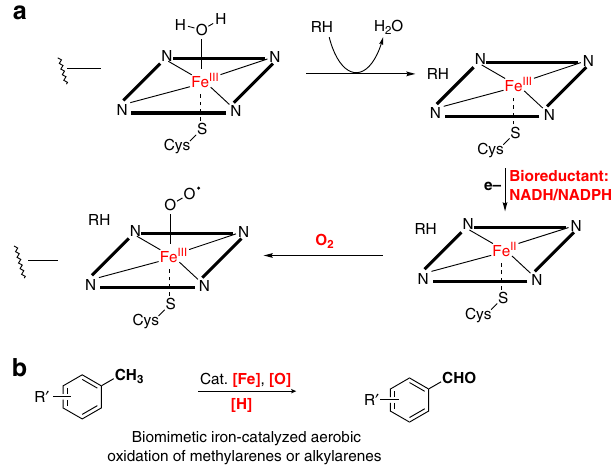
Fig. 1 Biocatalysis and biomimetic oxidation of hydrocarbons. a Biocatalysis: cytochrome P-450 cycle driven by a reductase or bioreductant. b This work: biomimetic iron